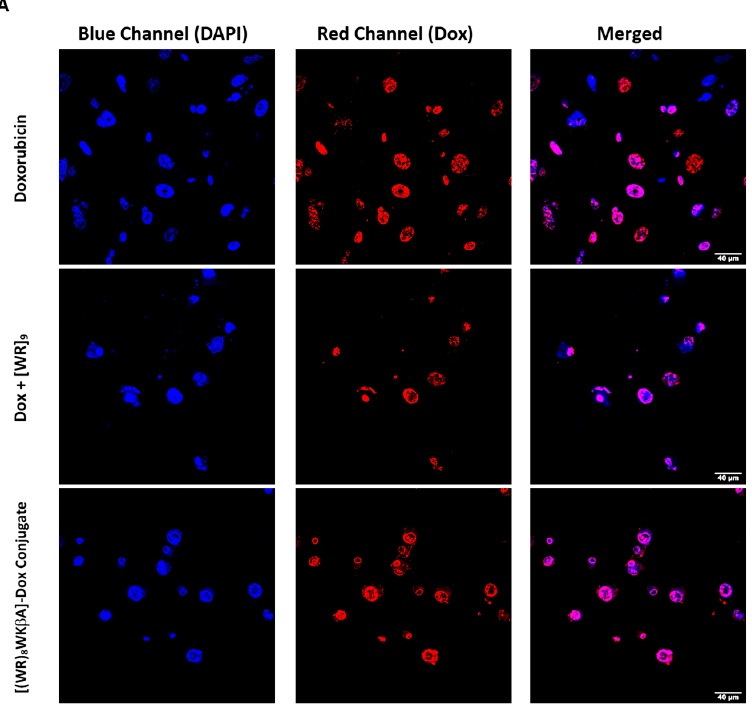
Figure 3. Confocal microscopy images of free Dox (5 µM), [WR] 9 + Dox (1:1, (5 µM)), or [(WR) 8 WK β A]-Dox conjugate (5 µM) after 24 h in ( A ) MDA-MB-231 and ( B ) MES-SA/MX2 cells. Red represents the fluorescence of Dox.